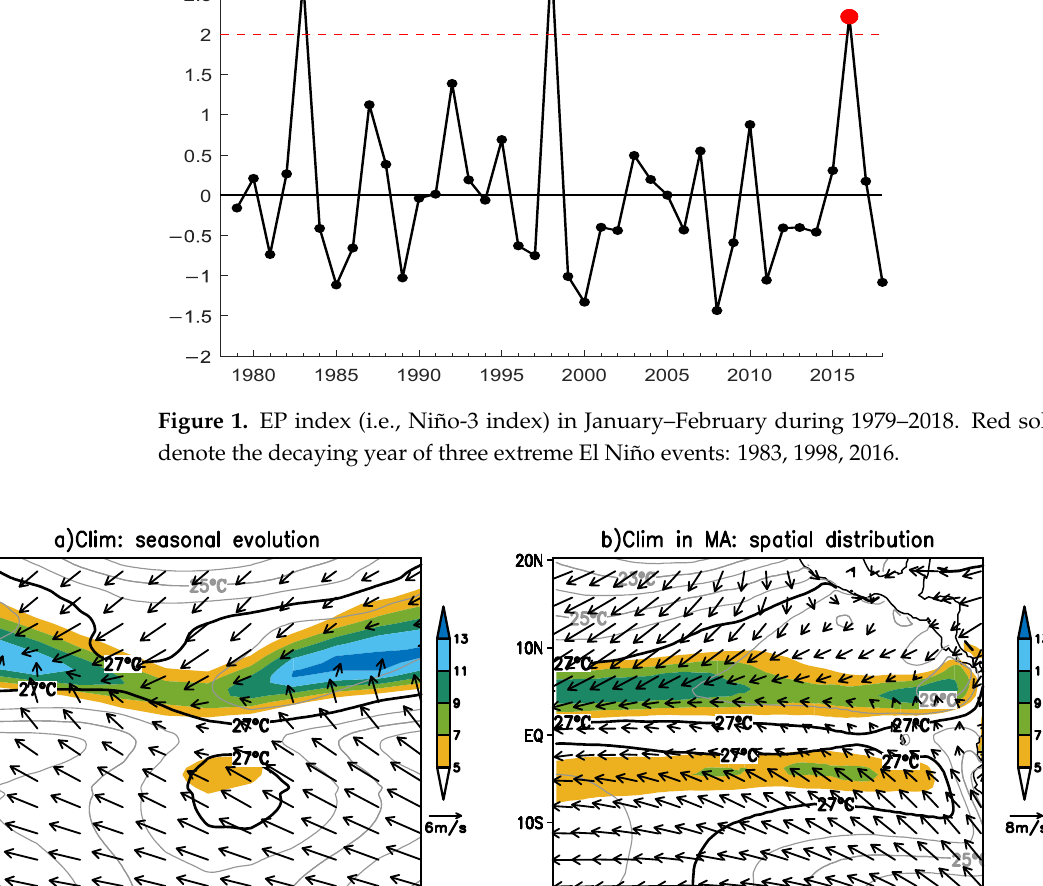
Figure 2. ( a ) Climatology: seasonal evolution of zonal-mean precipitation (color shaded; mm/day), SST (contours; °C), and surface winds (vectors; m/s) over the eastern Pacific (140°W–80°W); ( b ) Climatology in March–April: spatial pattern of the precipitation (color shaded; mm/day), SST (contours; °C), and surface winds (vectors; m/s; wind speed smaller than 1 m/s has been masked out) over the tropical eastern Pacific.